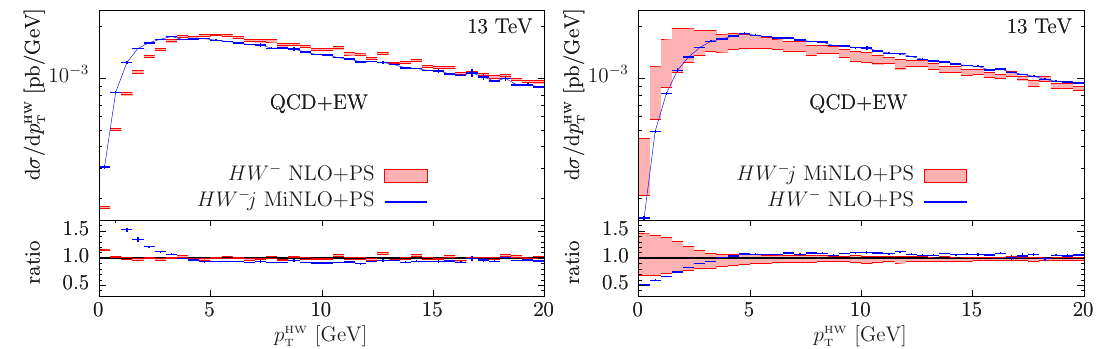
Figure 26. Comparison of NLO+PS and MiNLO +PS predictions for the distributions in transverse momentum of the HW (cid:0) system in HW (cid:0) production. Same curves and labels as in (cid:12)gure 25.